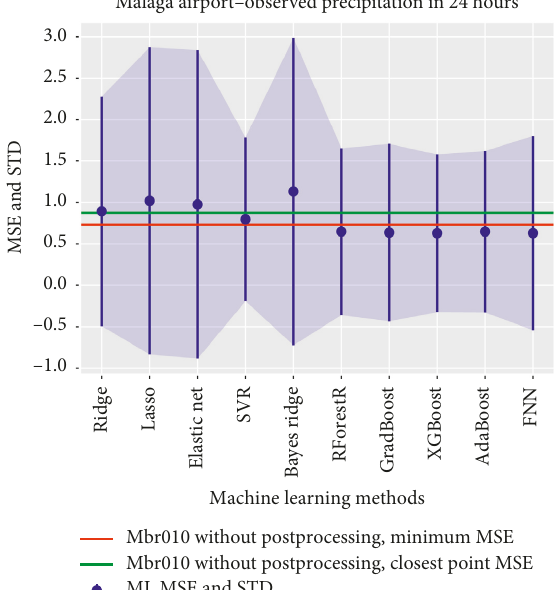
Figure 27: Precipitation in 24 hours, standardized calibration plot for M´alaga airport. Horizontal axis as in Figure